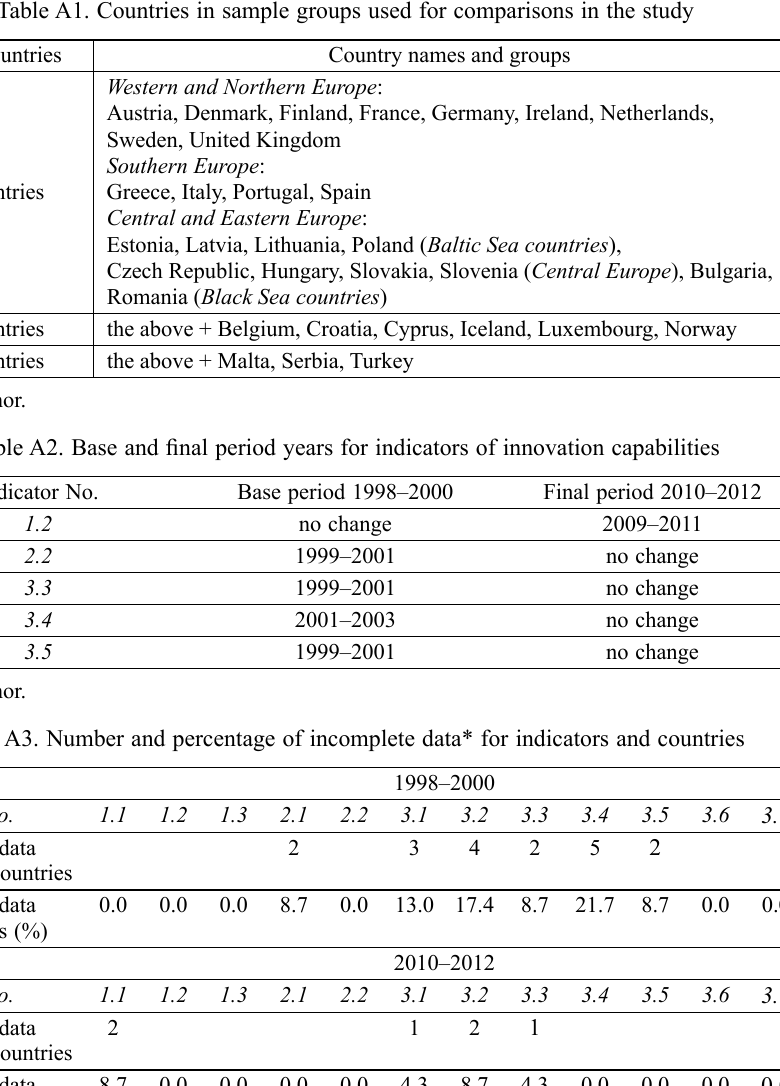
Table A1. Countries in sample groups used for comparisons in the study No. of countries